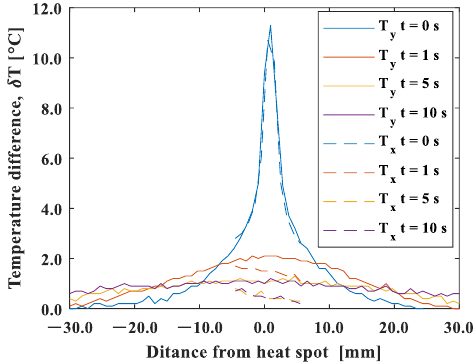
Figure 4. Temperature distribution around the heat spot.